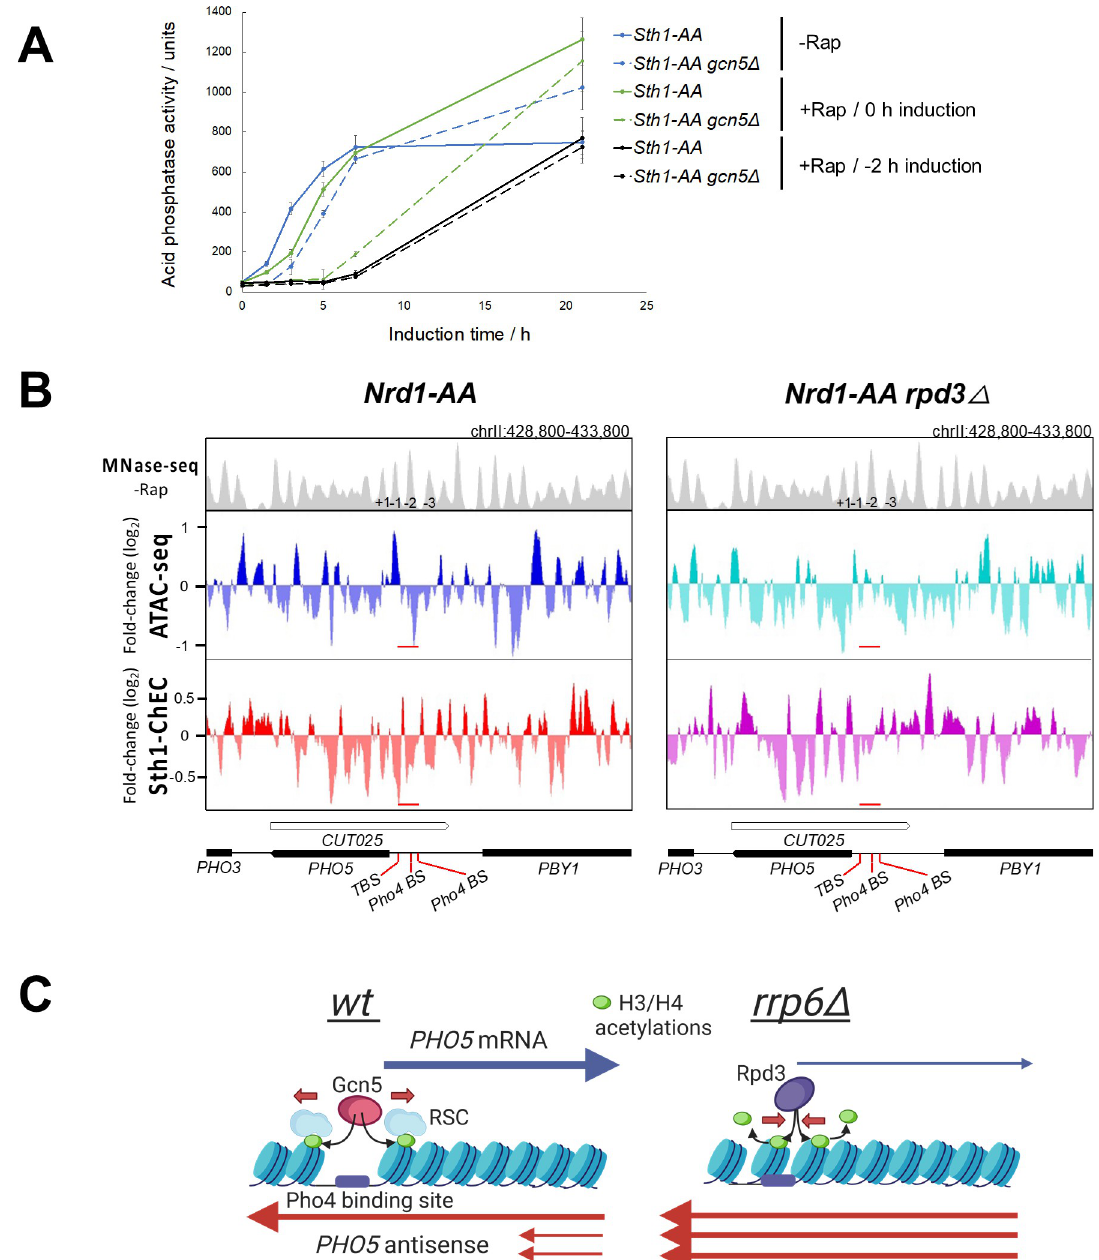
Fig 8. Chromatin remodeling at the PHO5 gene promoter is negatively affected by PHO5 AS elongation. (A) Acid phosphatase induction kinetics in Sth1-AA and the corresponding gcn5 Δ cells upon induction through phosphate starvation without (-Rap) or with addition of rapamycin (+Rap) at indicated times. Reported values represent the means and standard deviations of three independent experiments (n = 3). (B) Snapshot of the PHO5 gene locus in Nrd1-AA and the corresponding rpd3 Δ strain from MNase-seq (-Rap), ATAC-seq (+Rap/-Rap) and Sth1-ChEC (+Rap/-Rap) experiments. Data is from [13]. (C) Proposed model for how AS RNA regulates transcription of the PHO5 gene at the level of promoter chromatin structure. In wild-type cells, antisense RNA transcription is terminated by the NNS complex and degraded by the RNA exosome. Histones at the PHO5 gene promoter are acetylated by Gcn5 and serve as docking sites for recruitment of the chromatin remodeling complex RSC, thus enabling physiological kinetics of promoter opening and gene induction. In rrp6 Δ cells, read-through of the AS transcript into the PHO5 promoter region results in increased recruitment of the histone deacetylase Rpd3 and subsequently in hypoacetylation and decreased recruitment of RSC. This results in delayed kinetics of promoter opening and induction of the PHO5